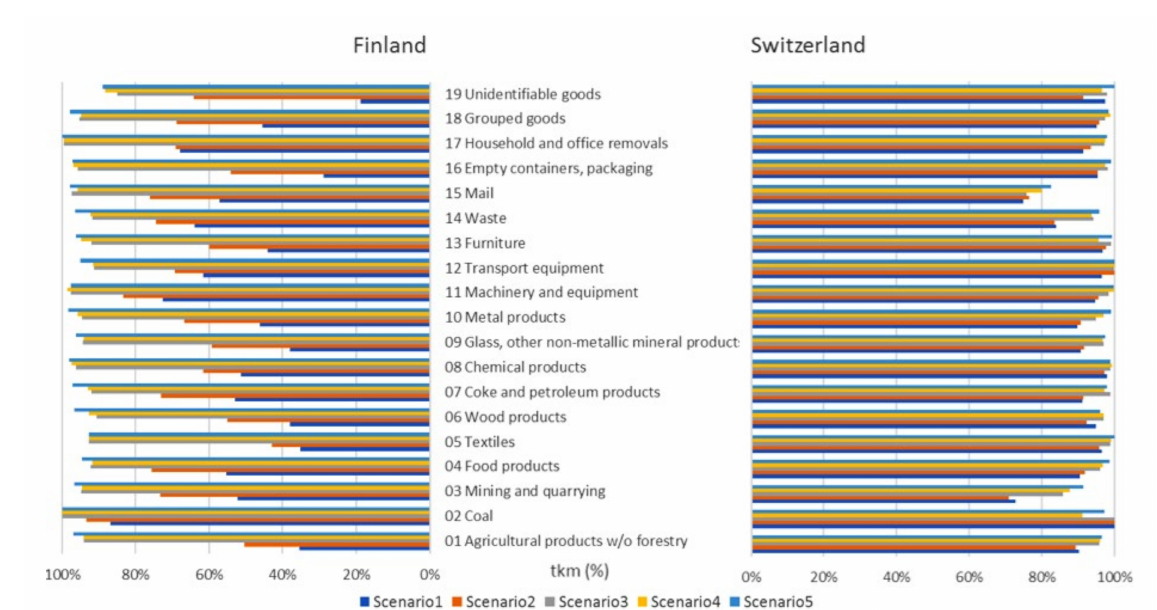
Figure 4. Comparative chart of manageable successful trips (share of tkm) in battery electric vehicle potential (BEVPO) model based on NST2007 [48] commodity groups in Finland and Switzerland.